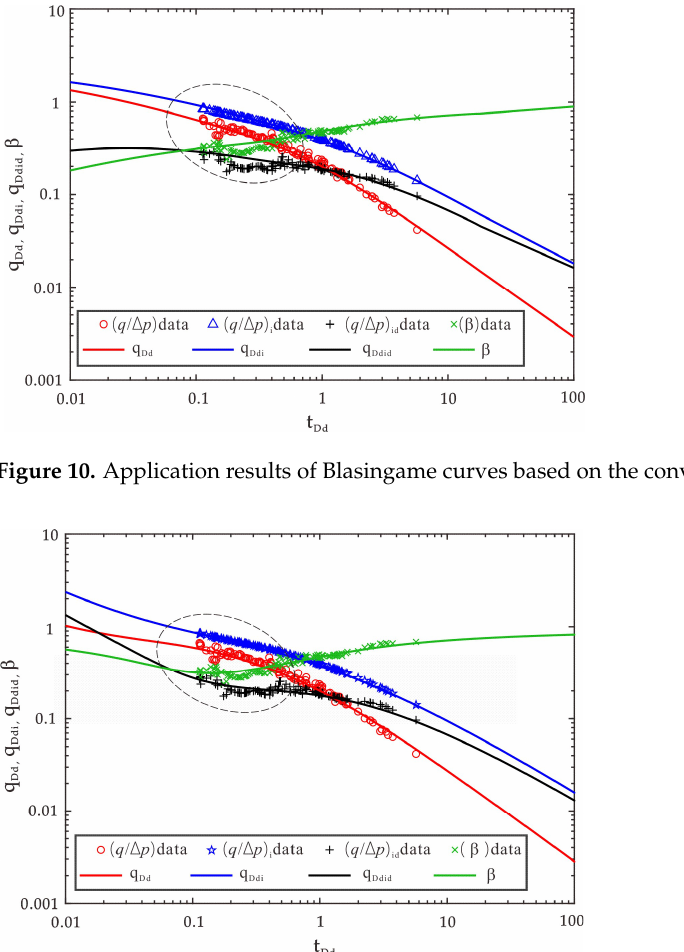
Figure 11. Application results of Blasingame curves based on the model presented in the paper.